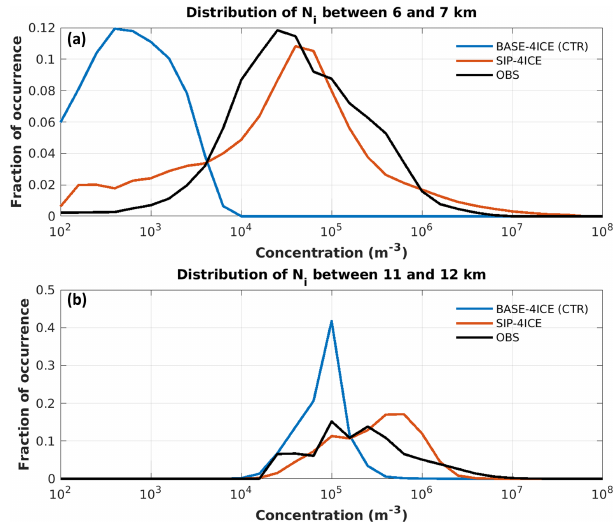
Figure 8. Distribution of N i for model simulations and for the observational data from the HAIC-HIWC aircraft campaign near French Guiana in May 2015. A logarithmic bin width of 1 / 5 of an order of magnitude is used. Panel (a) displays results from data be- tween altitudes of 6 and 7km and with an ice water content higher than 0.01gm − 3 . Panel (b) is the same as panel (a) but for altitudes between 11 and